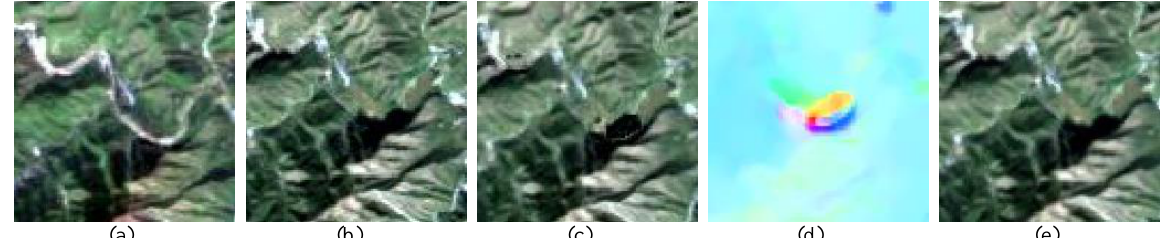
Figure 2. Registration result with optical flow algorithm. (a) Reference image. (b) Sensed image. (c) Registered image without post- processing (Brox et al. 2004). (d) Color map of displacement. (e) Registered image with displacement